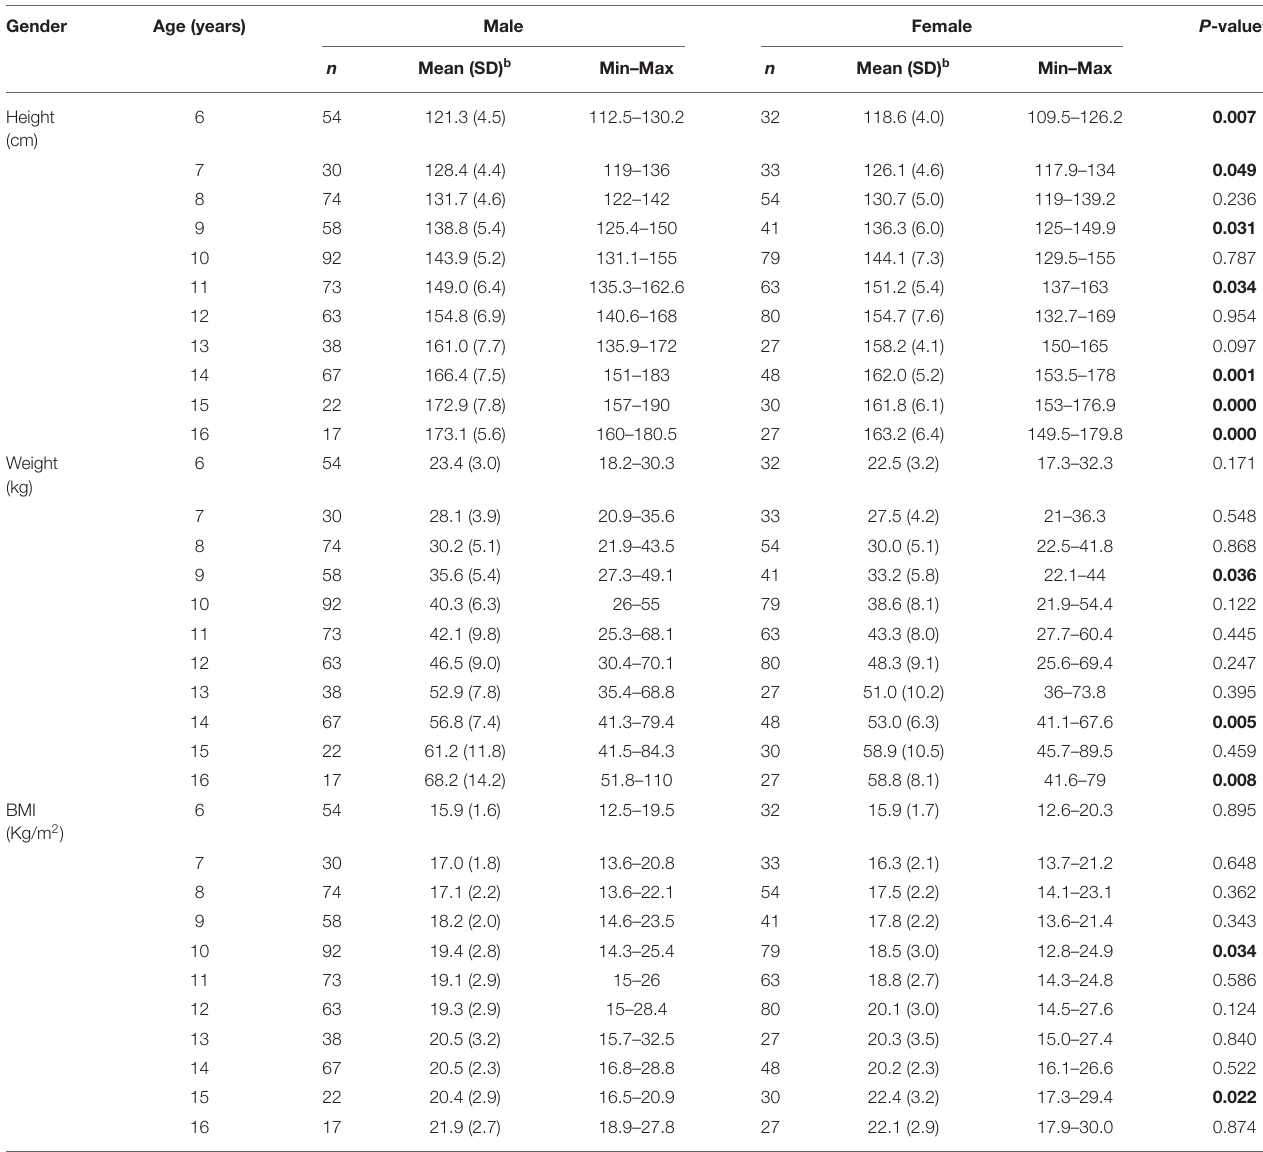
TABLE 1 | Descriptive statistics for demographic